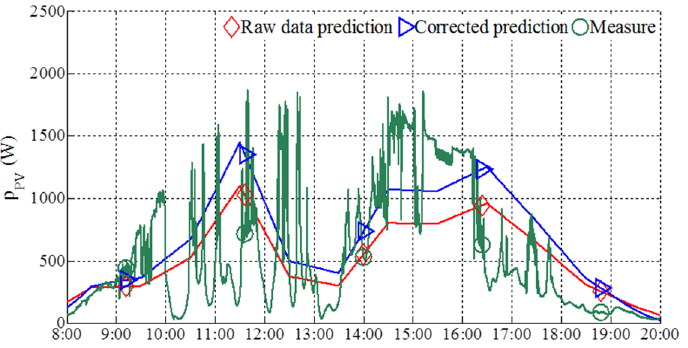
Figure 13. PV sources power prediction and actual PV sources power measure for Test 3.